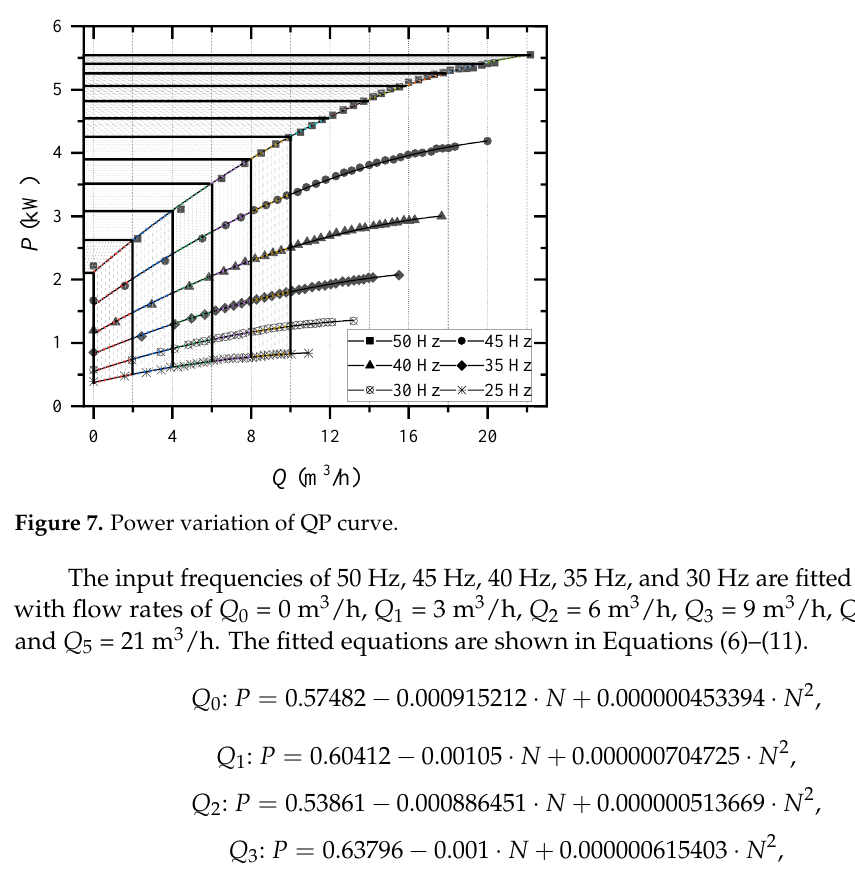
Figure 8 presents the fitted PN curves at different flow rates, and the relevant results of each curve are shown in Table 2. The coefficient of determination R 2 of all six fitted curves is close to 1, and the residual sum of squares (RSS) is close to 0, which indicates that the six curves have high accuracy and the results are reliable.